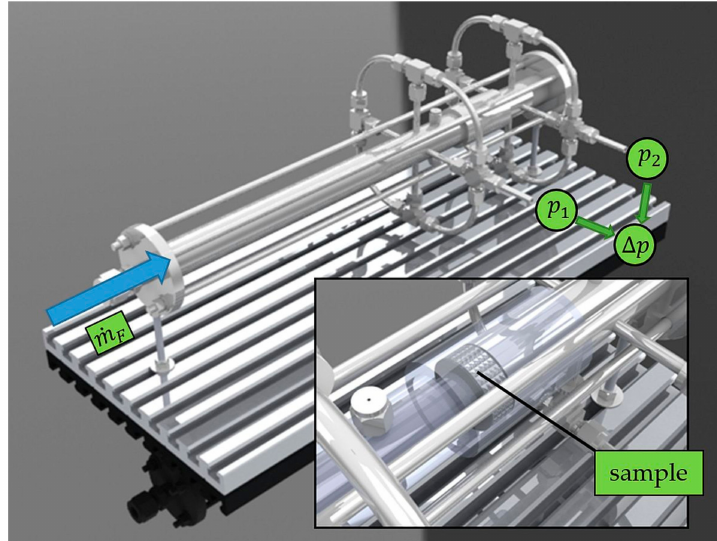
Figure 11. Construction of the cylindrical flow